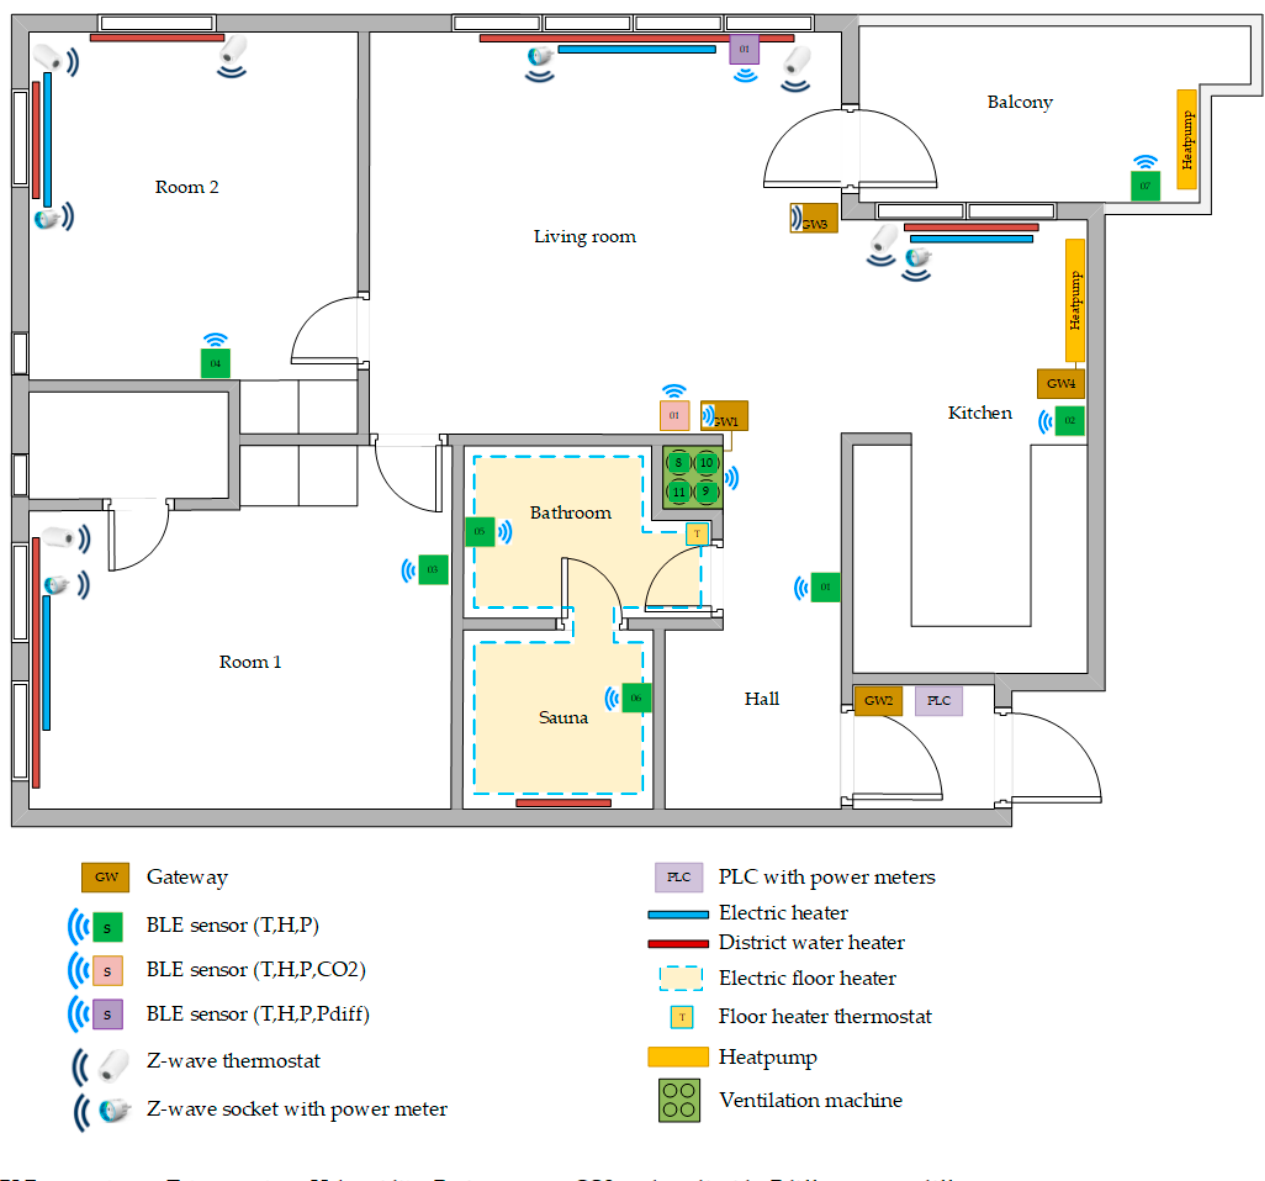
Figure 4. Floor map of residential load site with location of installed devices and ICT component.